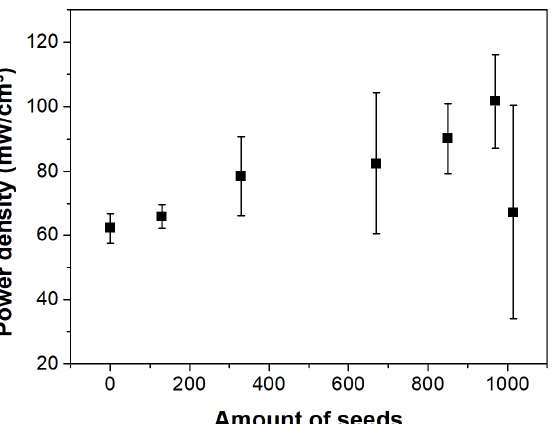
Figure 5. Influence of the number of seeds on the power density for zero (empty reactor) to around 1015 seeds (Petri dish bottom completely filled).